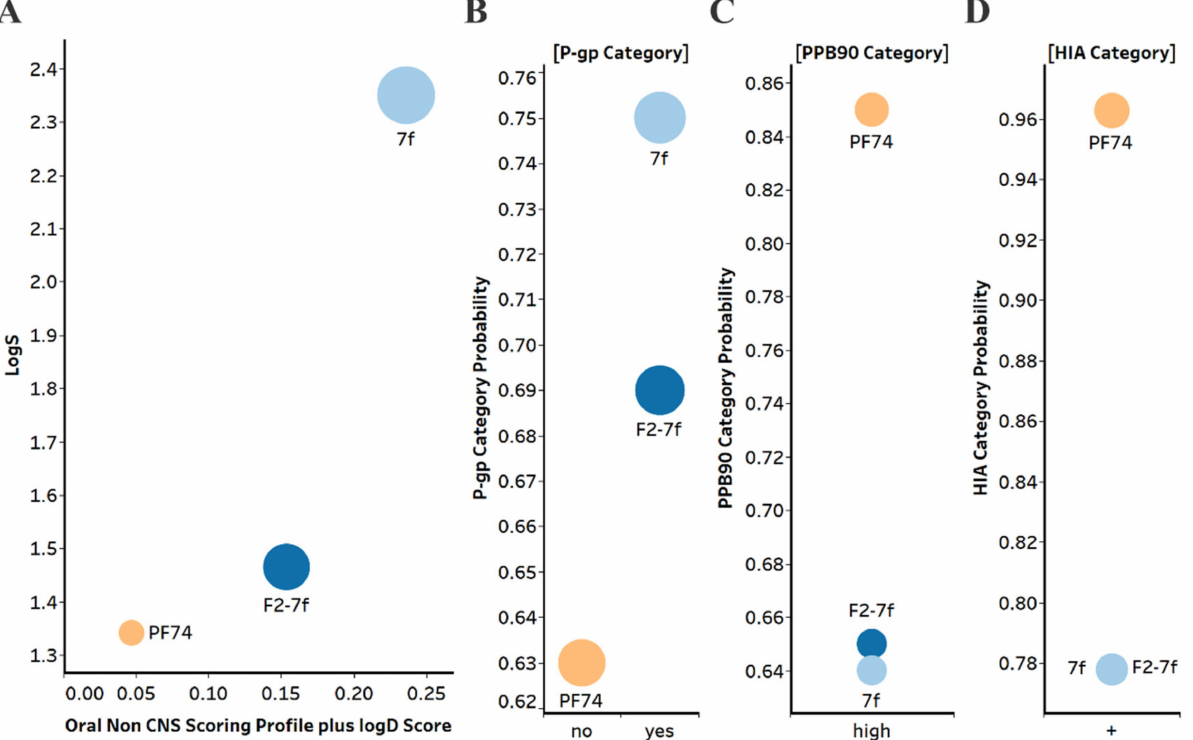
Figure 6. ( A ) Plot showing the StarDrop V7 (Optibrium, Ltd., Cambridge, UK)–derived logS versus a multimetric oral non-CNS profile score. Importance for the score: logS = 0.9, HIA = 0.85, logP = 0.6, logD = 0.6, hERG pIC50 = 0.4, 2D6 affinity category = 0.3, 2C9 pKi = 0.3, P-gp category = 0.3, PPB90 category = 0.2, BBB category = 0.11, BBB log(brain:blood) = 0.11 ( B ) P-gp category, ( C ) PPB90 = Plasma protein binding > 90%, ( D ) HIA = human intestinal absorption category, and probability of prediction of 7f , F 2 -7f and PF74 . The size of the circle correlates with the corresponding score or